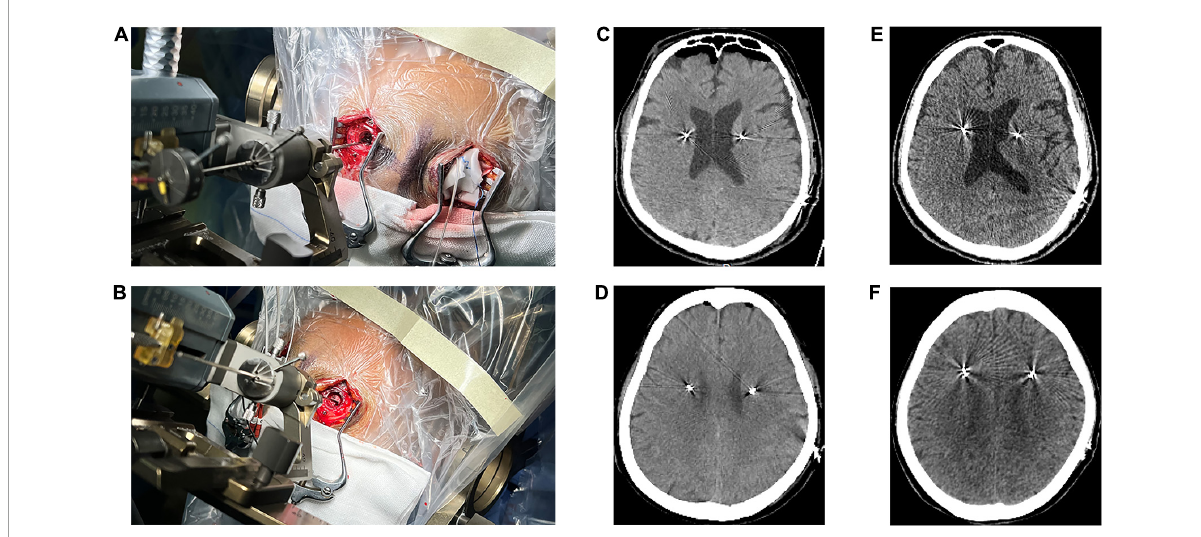
FIGURE1 Two different methods of opening the dura. (A) Dural incision. (B) Dural puncture. (C) Pneumocephalus on computed tomography (CT) immediately performed after surgery in a dural incision group patient. (D) Pneumocephalus on CT immediately performed after surgery in a dural puncture group patient. (E) CT performed one month after surgery in a dural incision group patient showed no pneumocephalus. (F) CT performed one month after surgery in a dural puncture group patient showed no